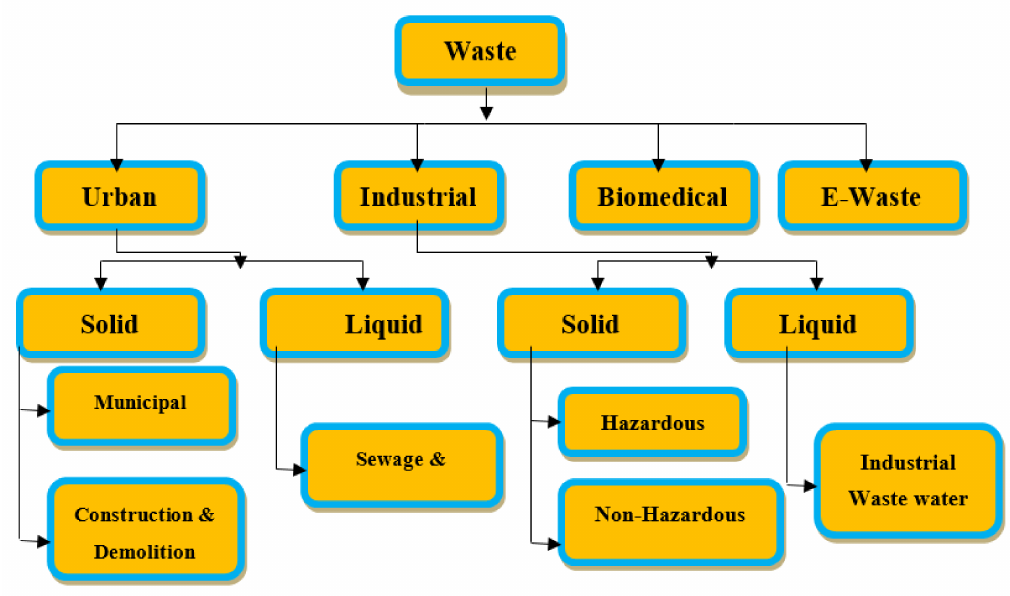
Figure 1. Anthropogenic wastes classification, (Reprinted with permission from